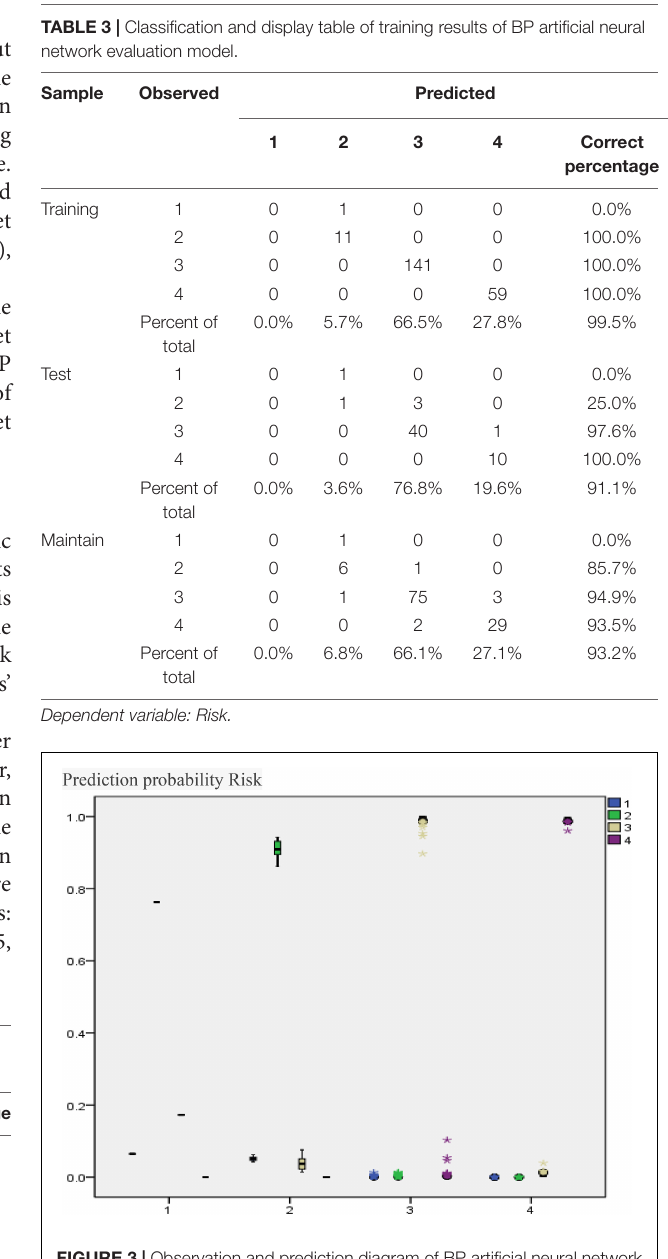
FIGURE 3 | Observation and prediction diagram of BP artificial neural network evaluation